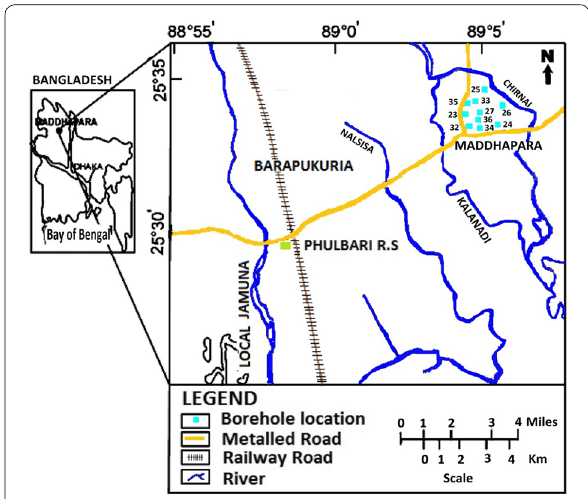
Fig. 1 Location map of Maddhapara Hardrock Mining Project (MHRMP) area (NAMNAM